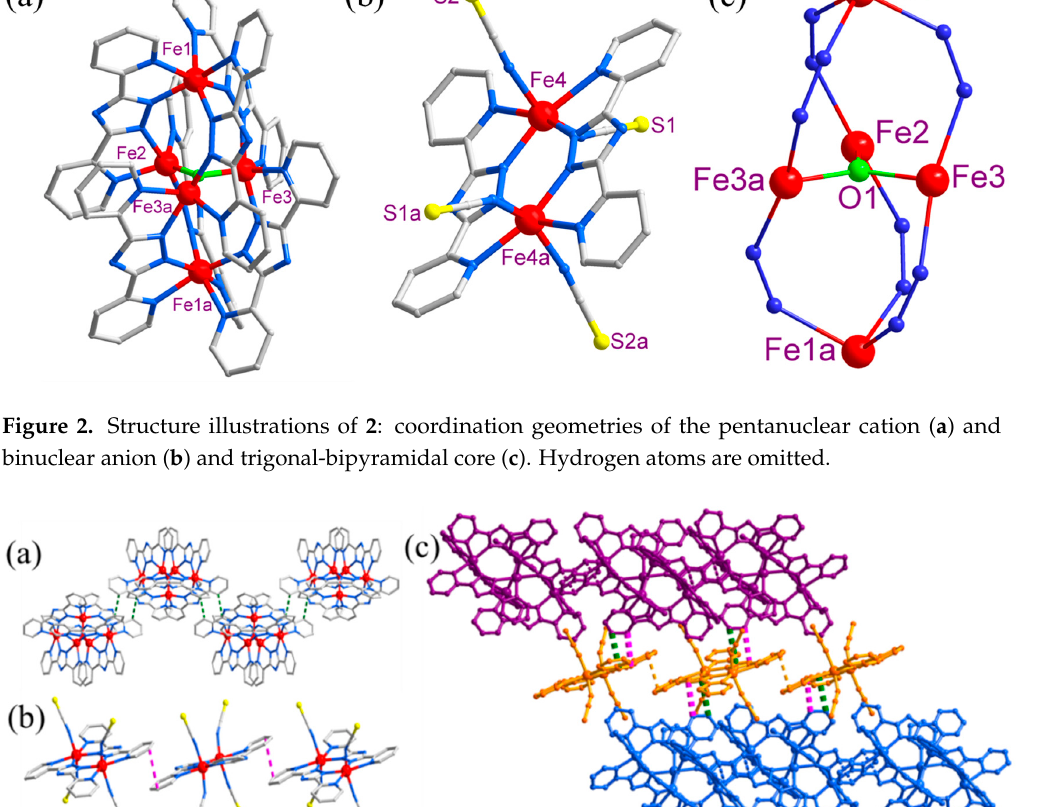
Figure 2. Structure illustrations of 2 : coordination geometries of the pentanuclear cation ( a ) and binuclear anion ( b ) and trigonal-bipyramidal core ( c ). Hydrogen atoms are omitted.